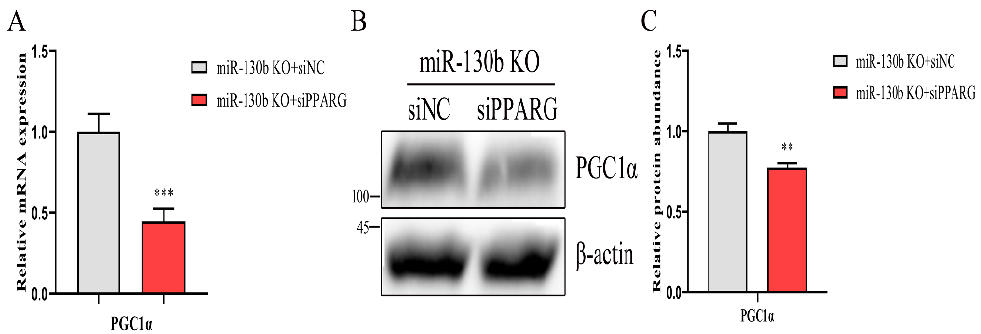
Figure 7. Silencing the expression of PPARG inhibits the PGC1 α expression in knockout cells. ( A ) Abundance detection of PGC1 α mRNA by RT-qPCR after reducing PPARG expression. ( B , C ) Detec- tion of the protein abundance of PGC1 α in GMEC transfected with PPARG siRNA or NC. Data are displayed as mean ± SEM. p < 0.05 and p < 0.01 are indicated as * and **.